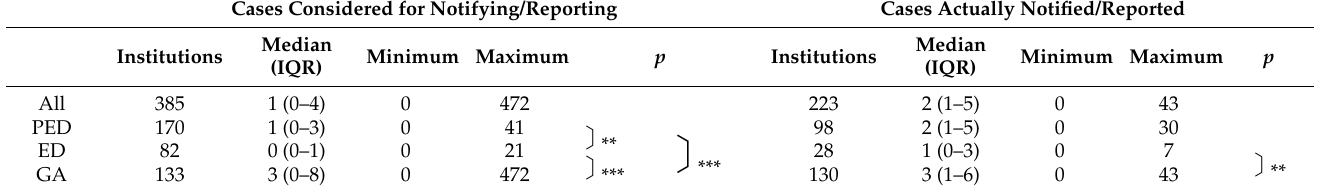
Table 2. Number of cases considered for notifying/reporting and the number of cases that were actually notified/reported.